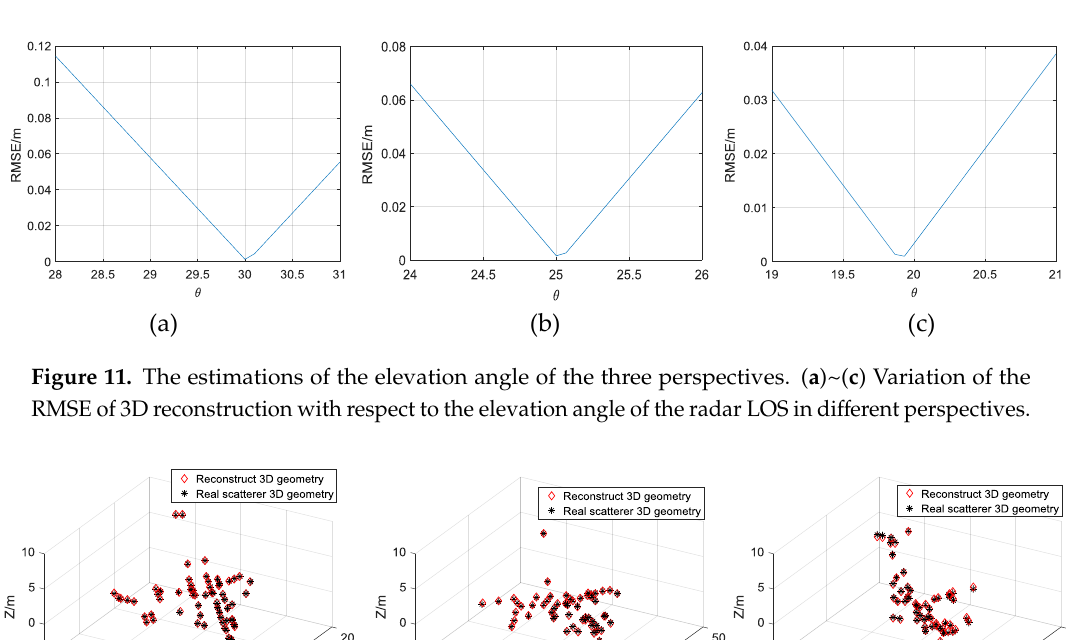
Figure 10. The model of experiment.